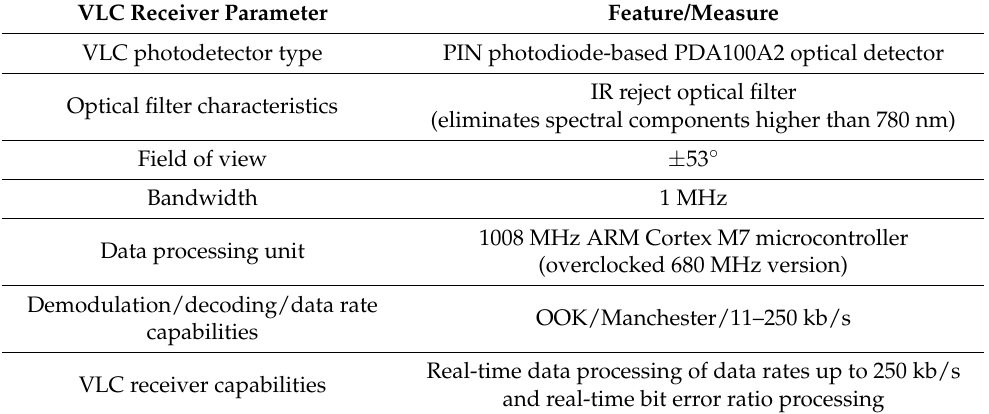
Table 2. Visible light communications receiver